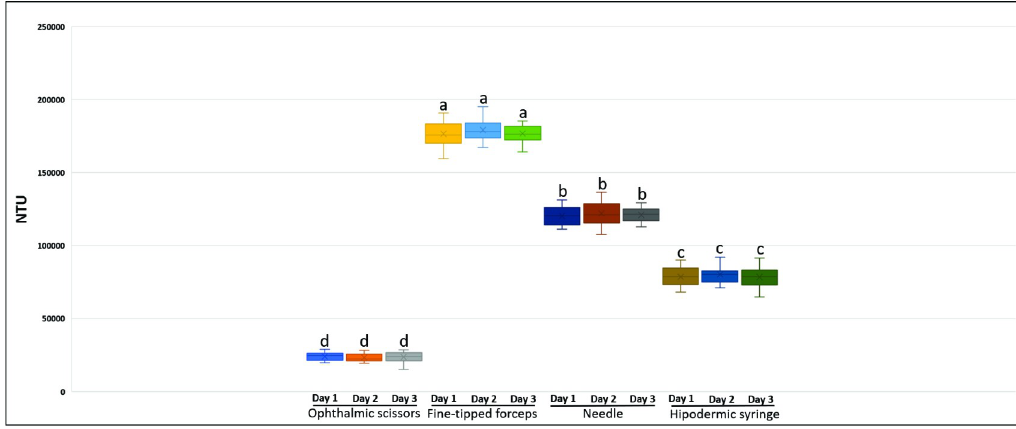
Fig 6. Boxplots comparing the hemolymph samples’ turbidity extracted from the different methods of extraction of hemolymph from fifth instar larvae A . mellifera tested on three different days. Boxplots followed by the same letter do not differ by Tukey’s test at a 1% probability of error (p <